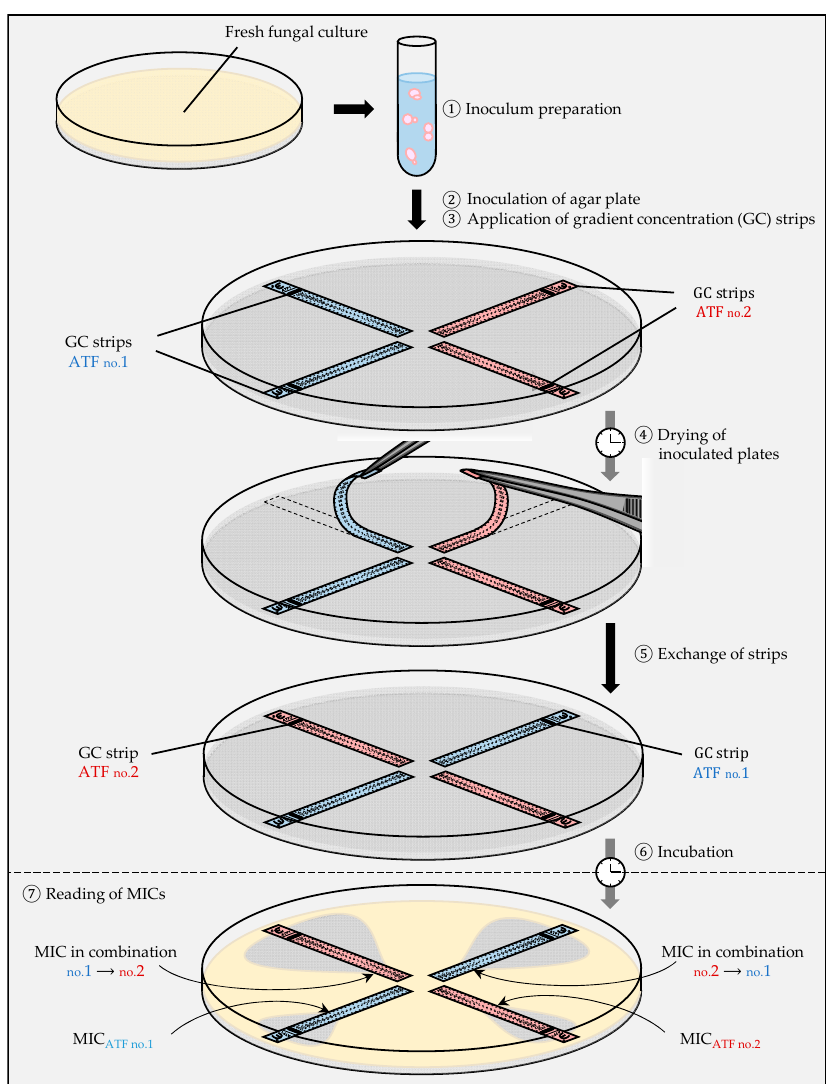
Figure 3. Gradient concentration strip method (Etest) for the determination of antifungal interactions: the fixed ratio protocol.